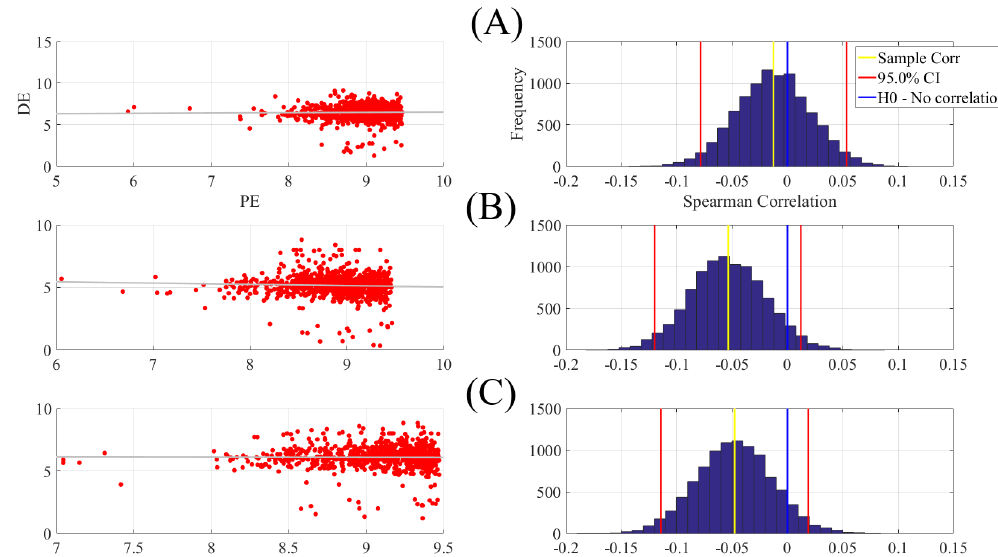
Figure A17. Spearman correlation between participants’ DEs (i.e., 62 DEs associated with 62 EEG channels of a participant, per affect) and their corresponding PE6 values (i.e., 62 PE6s associated with 62 EEG channels of a participant, per affect) in ( A ) negative, ( B ) neutral, and ( C ) positive. The subplots on the right column correspond to the bootstrap correlation test (10,000 simulation runs) at 95.0% confidence